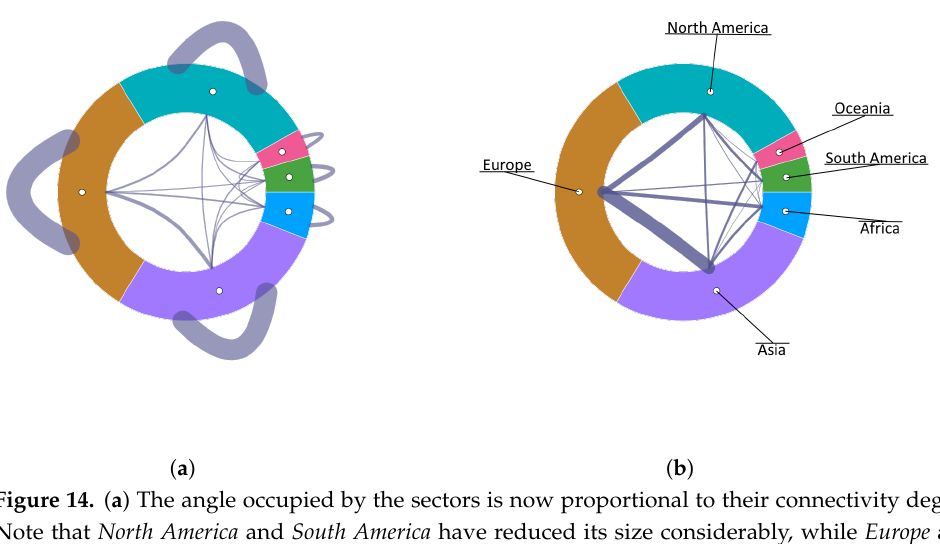
Figure 14. ( a ) The angle occupied by the sectors is now proportional to their connectivity degree. Note that North America and South America have reduced its size considerably, while Europe and Asia have increased it significantly. ( b ) When removing self-connections and focusing on external connections, we observe that Europe and Asia are the two most highly connected